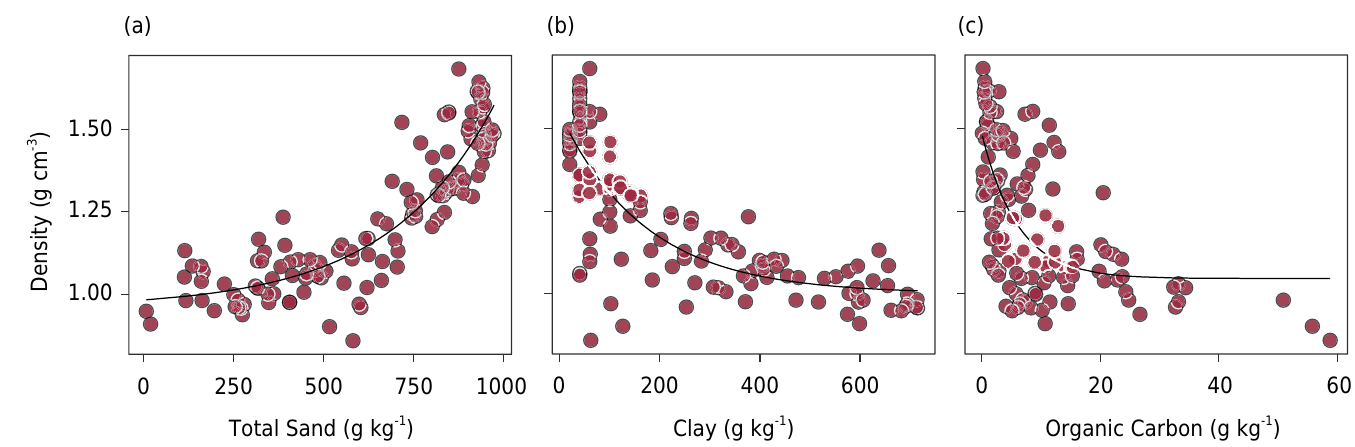
Figure 4. Scatterplot of total sand vs. density (a); clay vs. density (b); and organic carbon vs. density